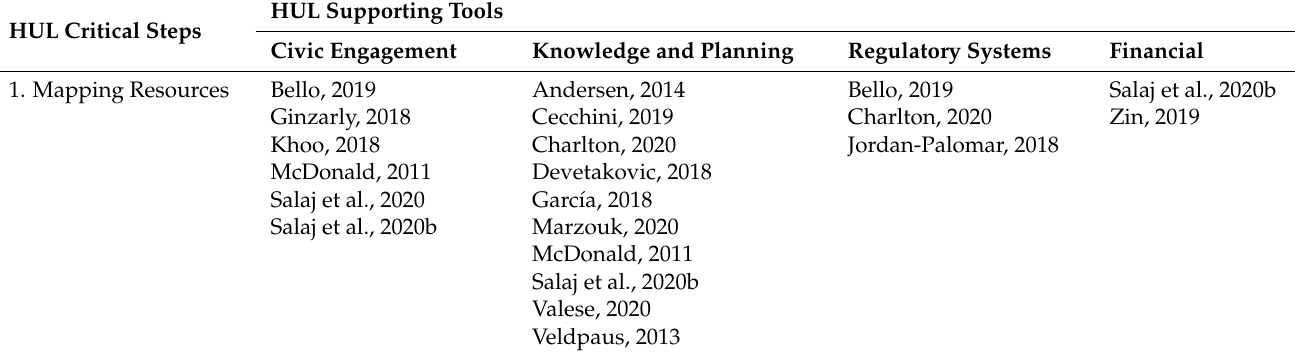
Table 1. List of authors discussing the mapping-resources supporting tools of the HUL approach within the urban heritage facility management field. HUL Critical